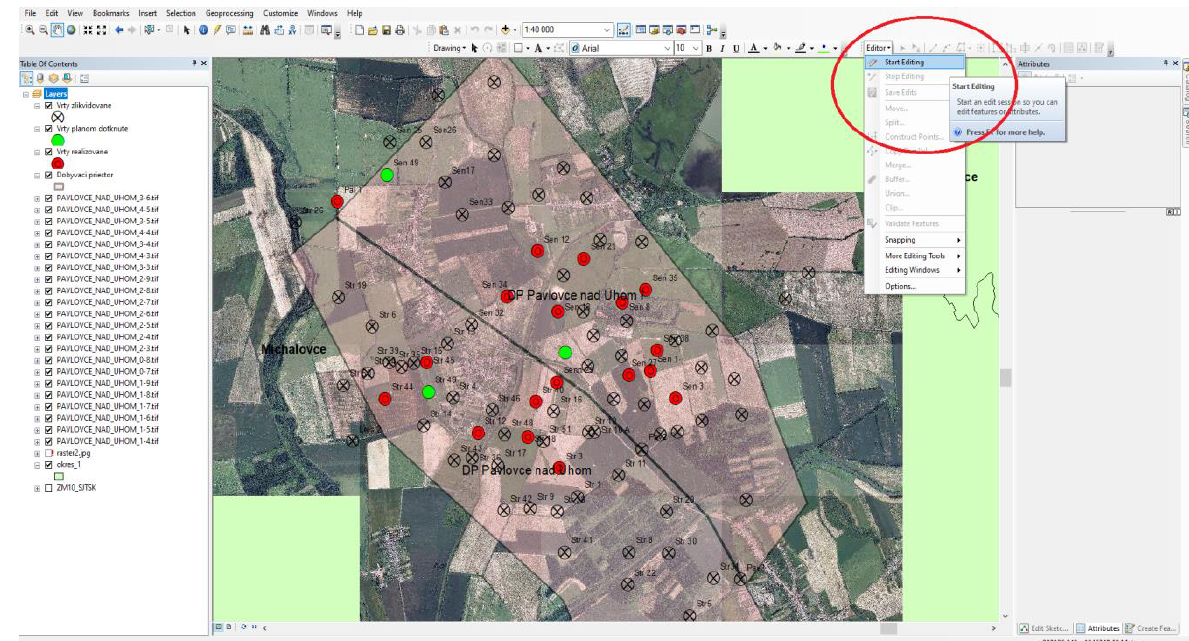
Figure 6. Placement of the wells in mining areas, (source: elaborated by authors).